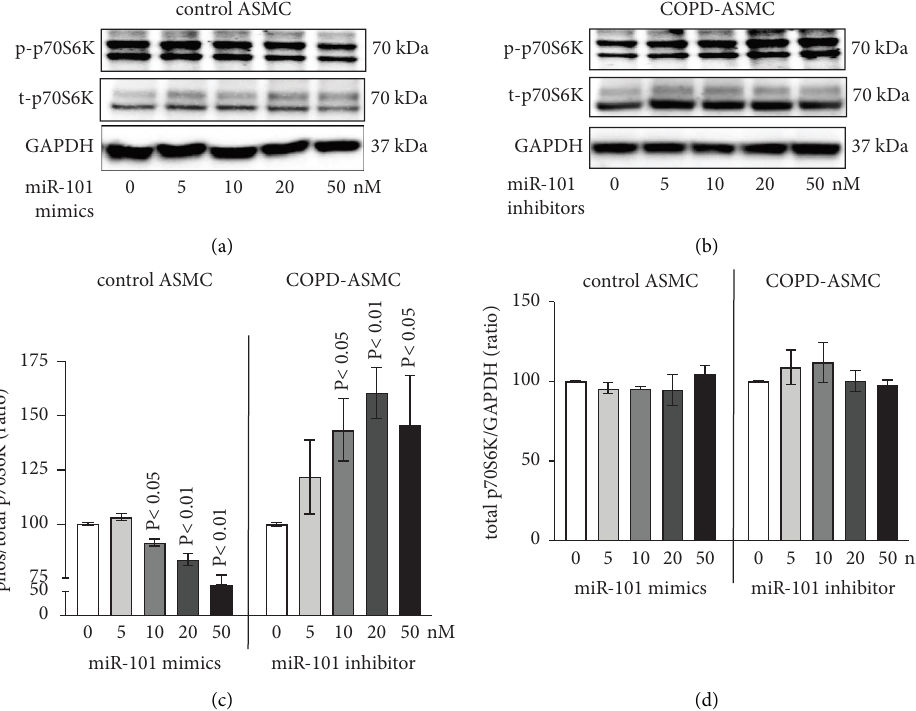
Figure 5: Te efect of miR-101-3p on mTOR signaling pathway. (a) Concentration-dependent modifcation of phosphorylation (p-) p70S6K by miR-101-3p mimics in ASMC of healthy nonsmokers (control, n � 3). (b) Concentration-dependent modifcation of phos- phorylation (p-)p70S6K by miR-101-3p inhibitors in COPD-ASMC ( n � 3). (c) Comparison of the p-/t- p70S6K ratio in fve Western blots of ASMC from healthy nonsmokers (control) to COPD by image analysis (Figures 5(a) and 5(b)). Bars represent mean ± S.E.M. P values were calculated by comparison to untreated cells. (d) Comparison of the t-p70S6K/GAPDH ratio in fve Western blots in ASMC from healthy nonsmokers (control) to COPD by image (Figures 5(a) and 5(b)). Bars represent mean ±